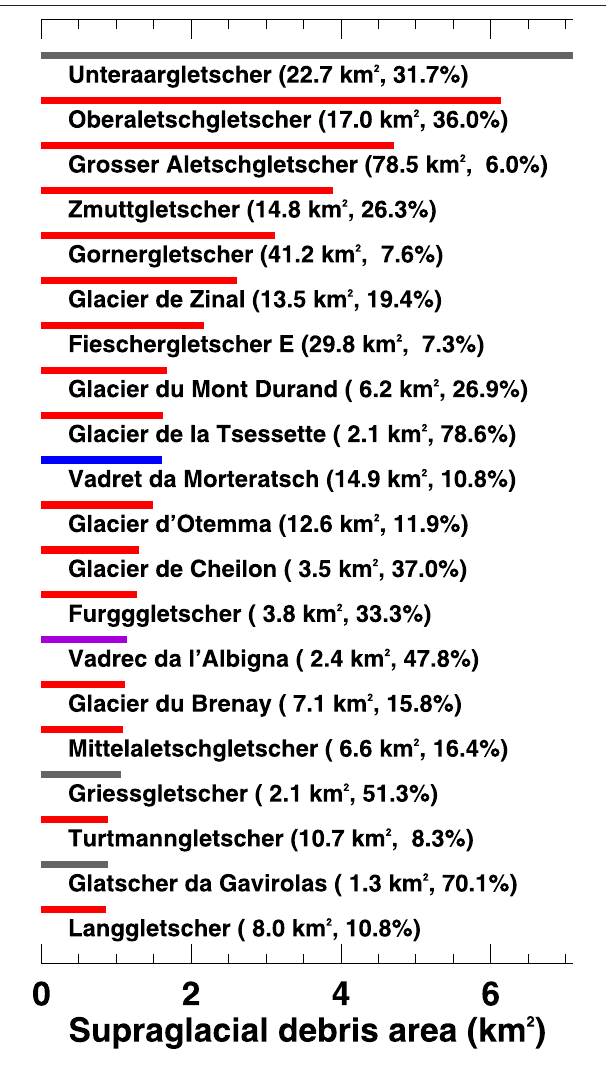
Frontiers in Earth Science |